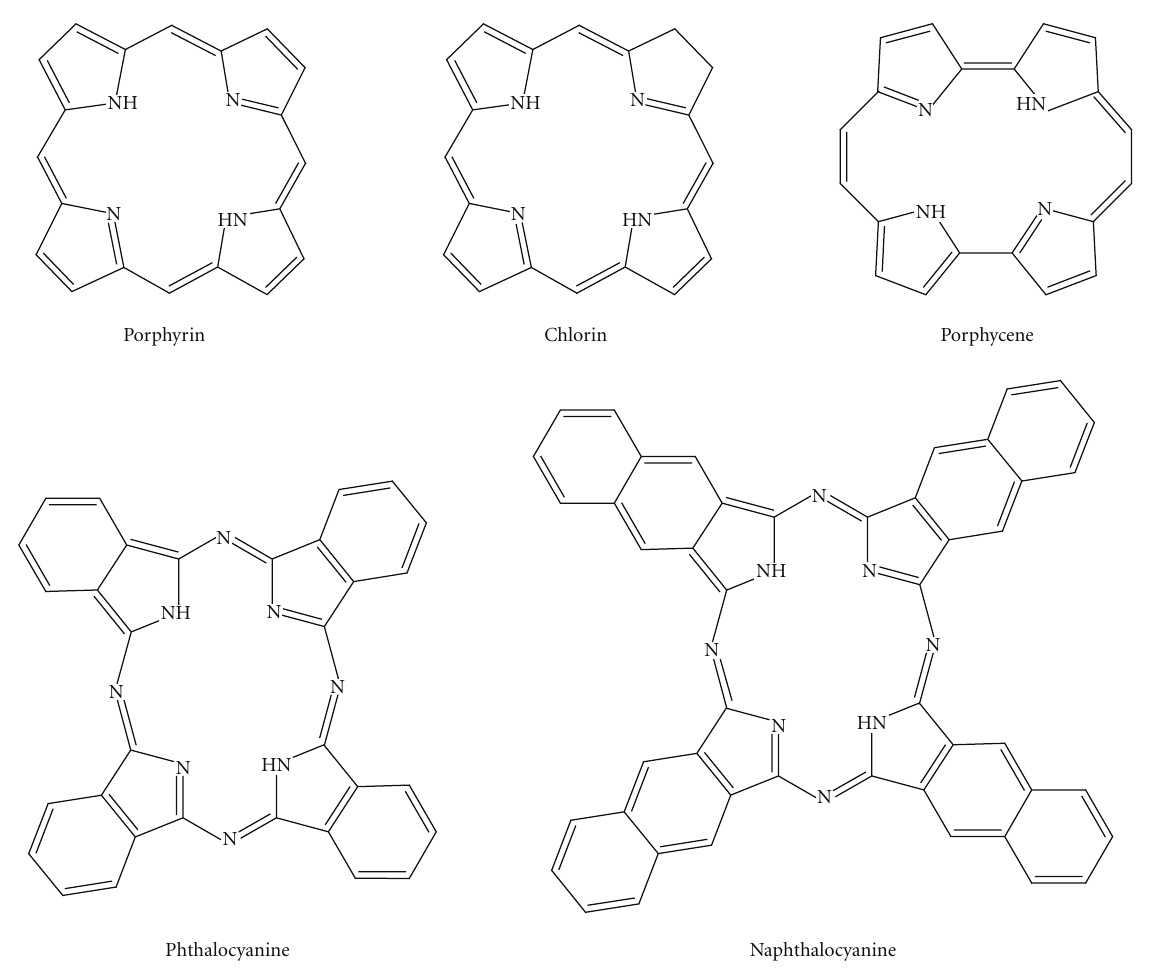
Figure 1: Chemical structures of major PDT photosensitizers.